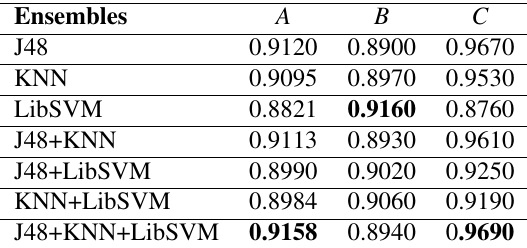
Table 4. The training results with DATASET2 .